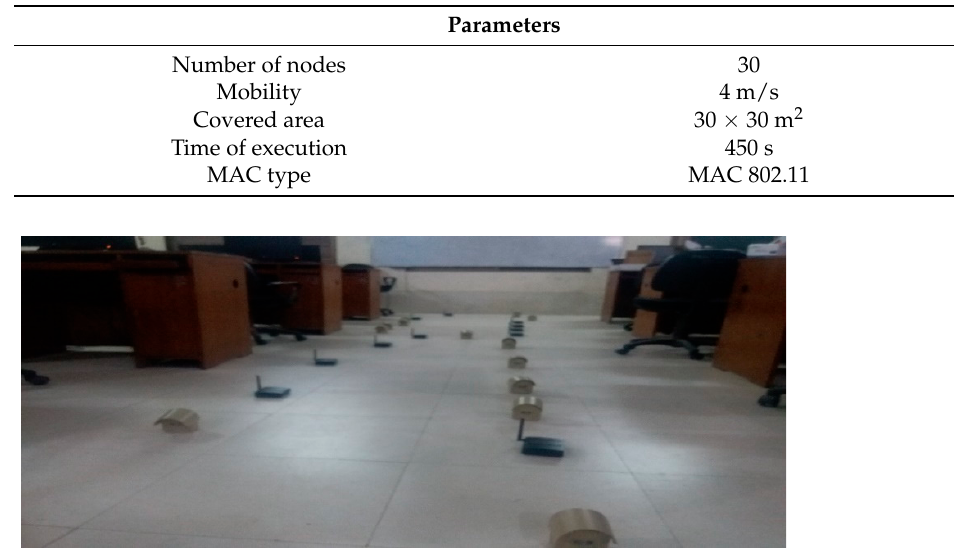
Figure 7. Sensor. Table 2. Parameters of Testbed.